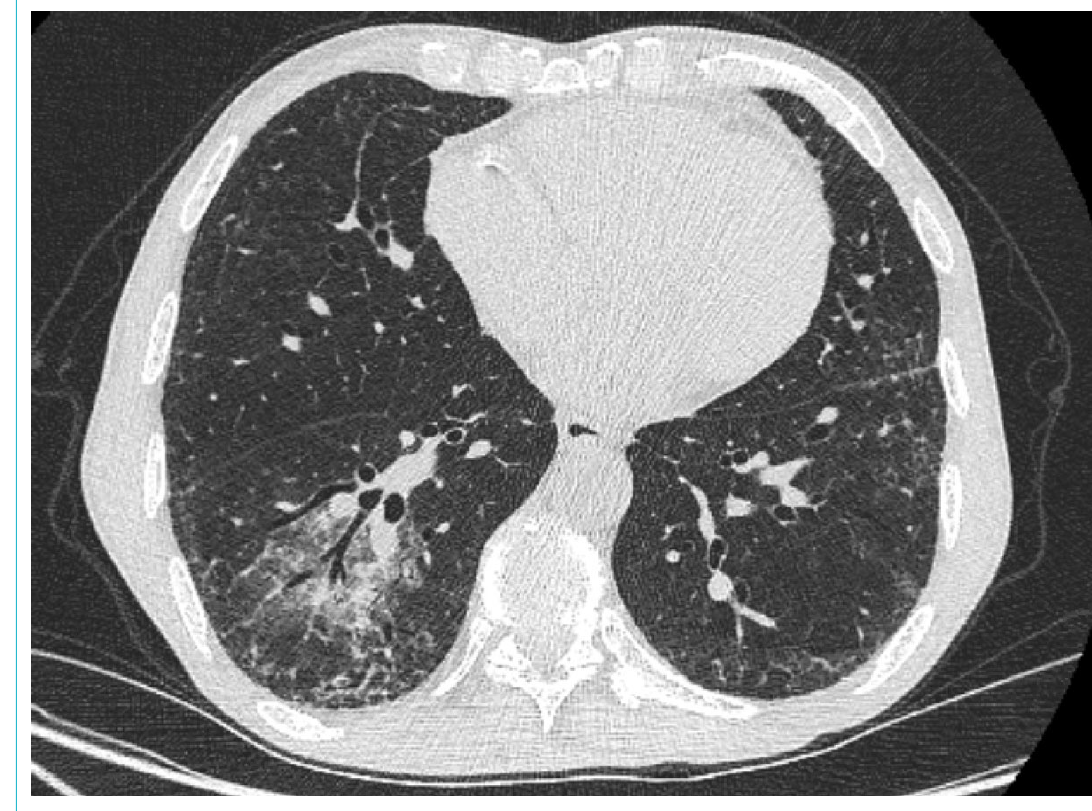
Figure 5: Chest computed tomography 3 months later showed global improvement, with a persistent ground glass opacity in the lower right lobe and posterobasal subpleural